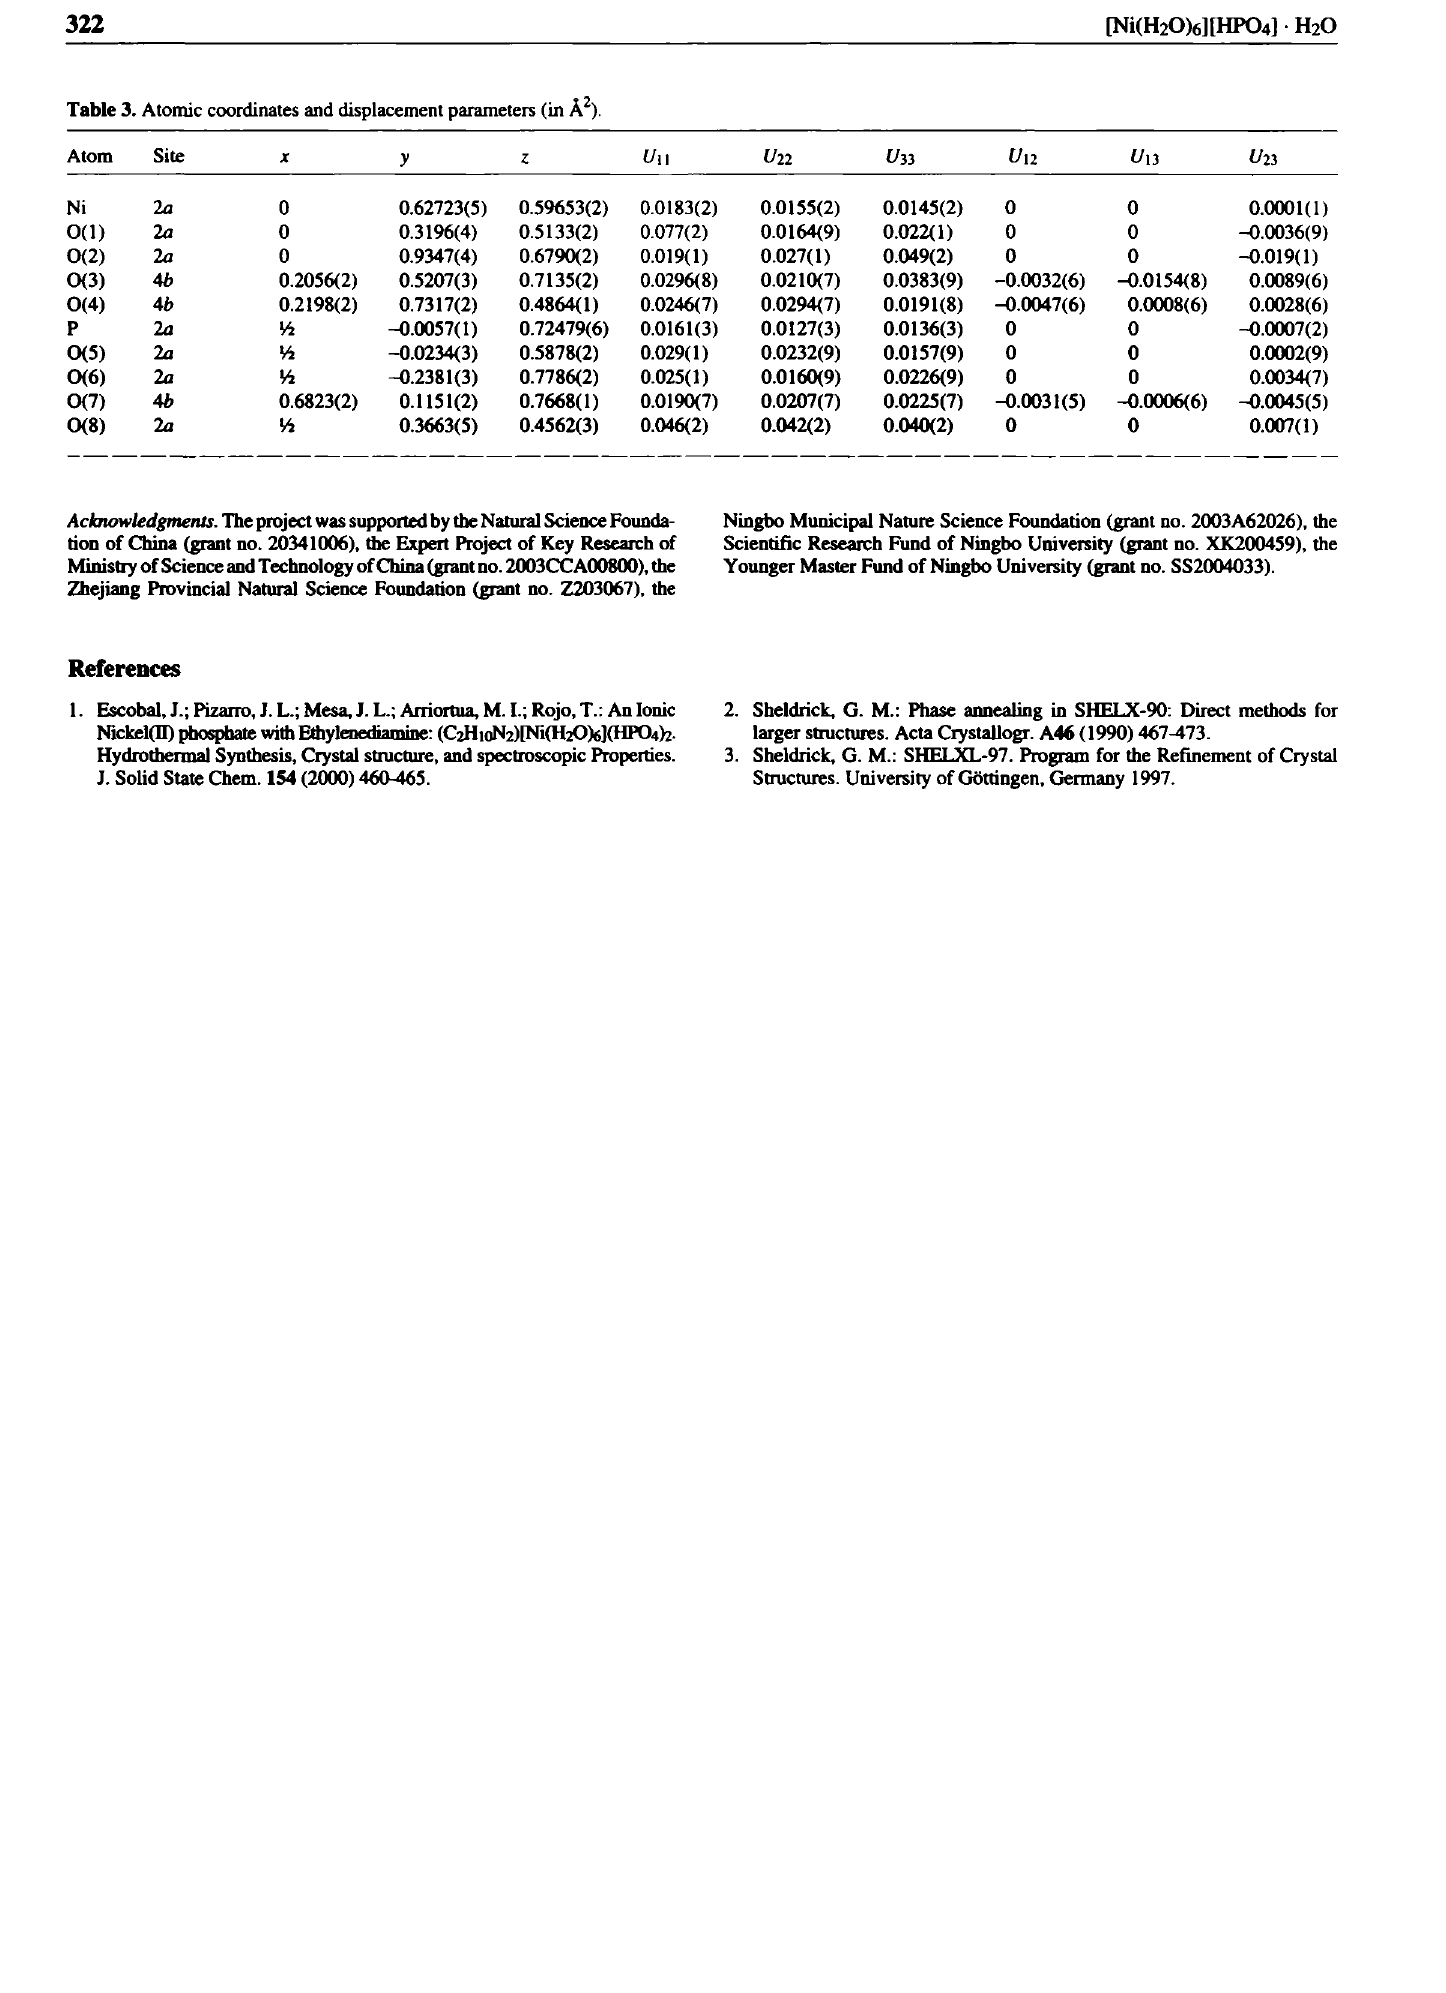
Table 3. Atomic coordinates and displacement parameters (in A 2